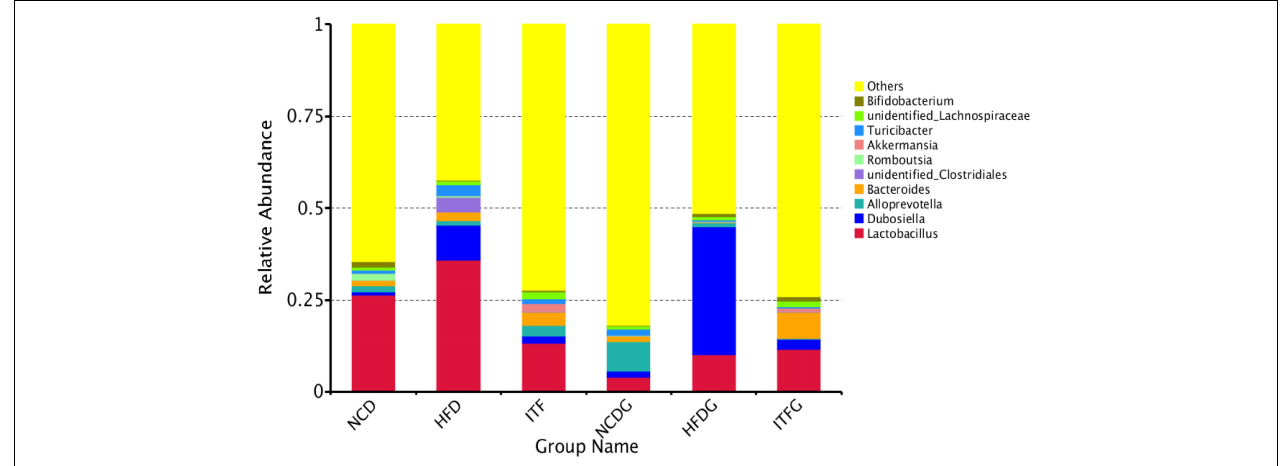
FIGURE 5 | Relative abundance of microbial species of the top 10 genera in the feces of mice.